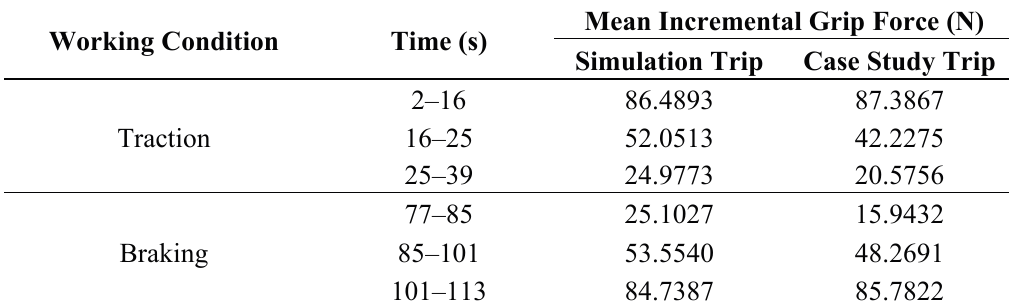
Table 9. Incremental grip force of simulation trip and case study